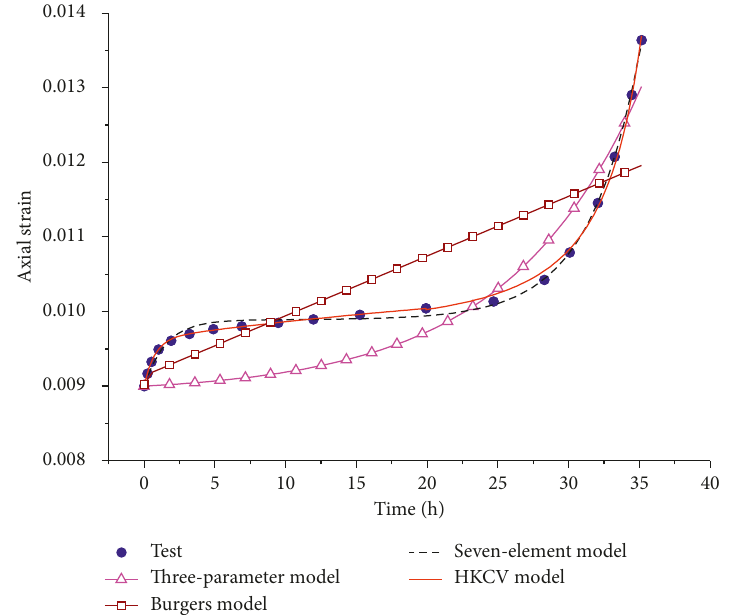
Figure 9: Comparison between test value and model values (under saturated condition, σ